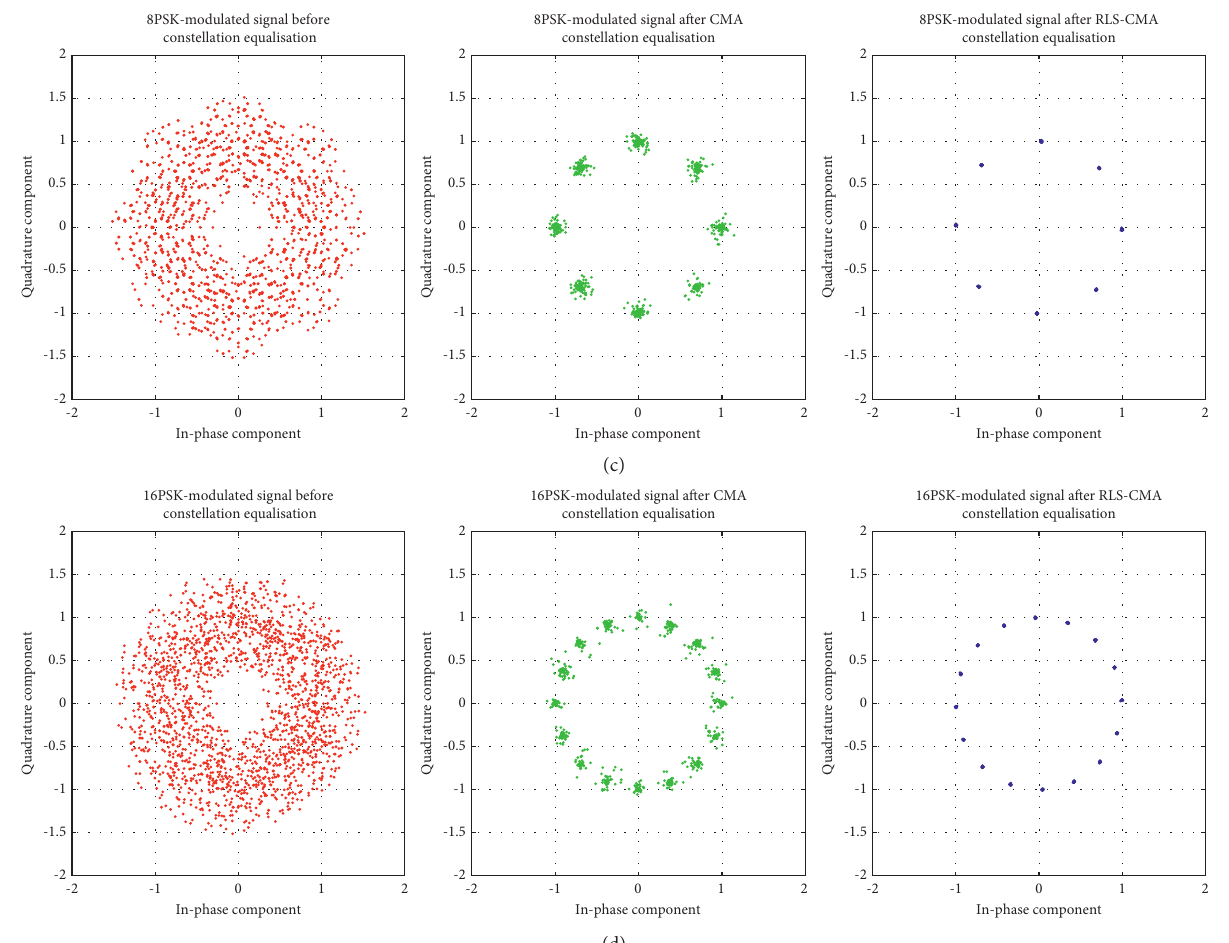
Figure 11: Constellations of different modulated signals obtained by the RLS-CMA blind equalisation algorithm. (a) BPSK modulation (SNR � 55dB). (b) QPSK modulation (SNR � 55dB). (c) 8PSK modulation (SNR � 55dB). (d) 16 PSK modulation (SNR �